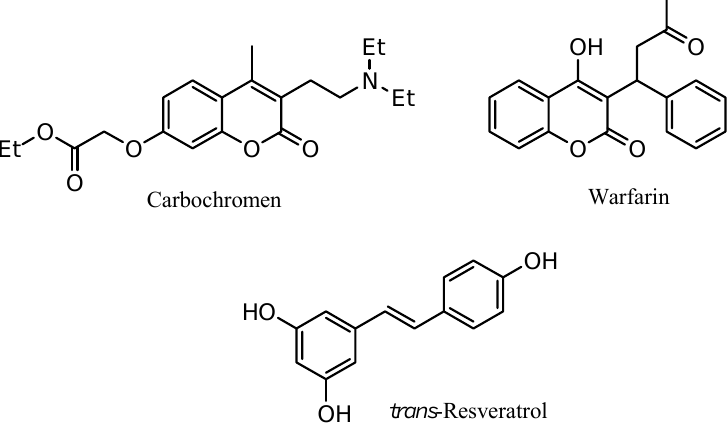
Figure 1. Chemical structures of trans -resveratrol, carbochromen, and